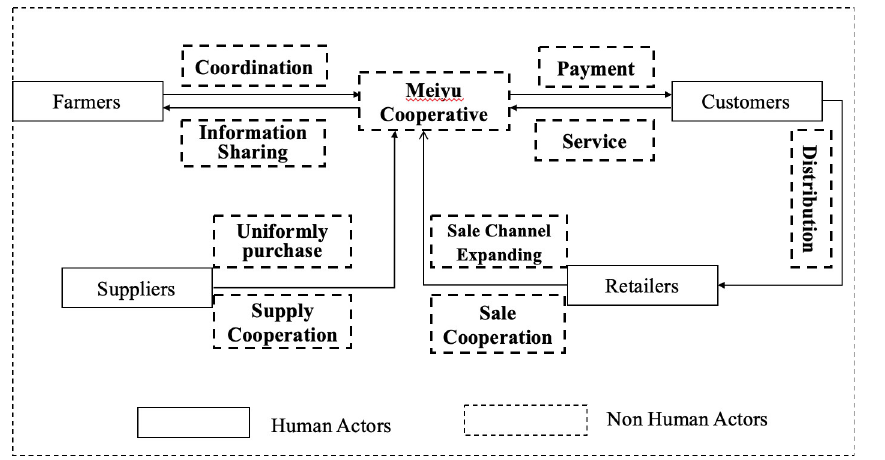
Fig 6. Start-up stage and development